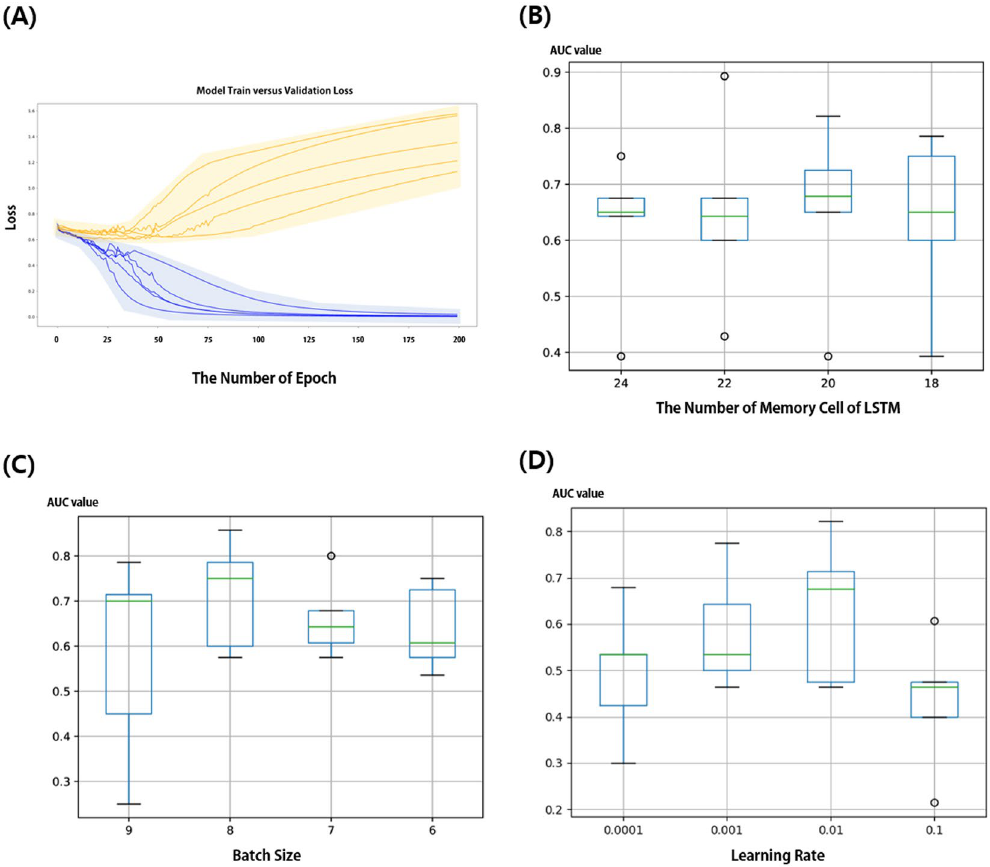
Figure 2. Parameter tuning process. In the training set (N = 59), 20 percent was separated into validation sets. ( A ) Tracing plot representing both train (blue lines) and validation loss (orange lines) through five iterations when learning rate was 0.001, the number of memory cells in LSTM was 24, and batch size was 7. Box and whisker plots depict statistics collected from 5-fold validation, comparing AUC values when ( B ) memory cell size of LSTM was 18, 20, 22, or 24 ( C ) batch size was 6, 7, 8 or 9, and ( D ) learning rate was 0.0001, 0.001, 0.01 and 0.1.